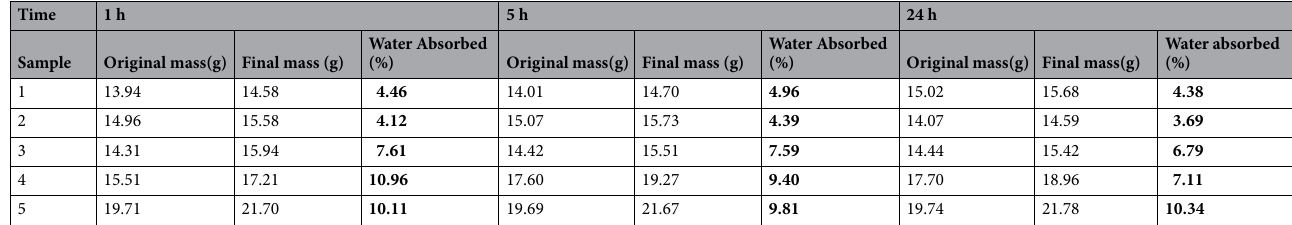
Table 5. Moisture absorption test results.